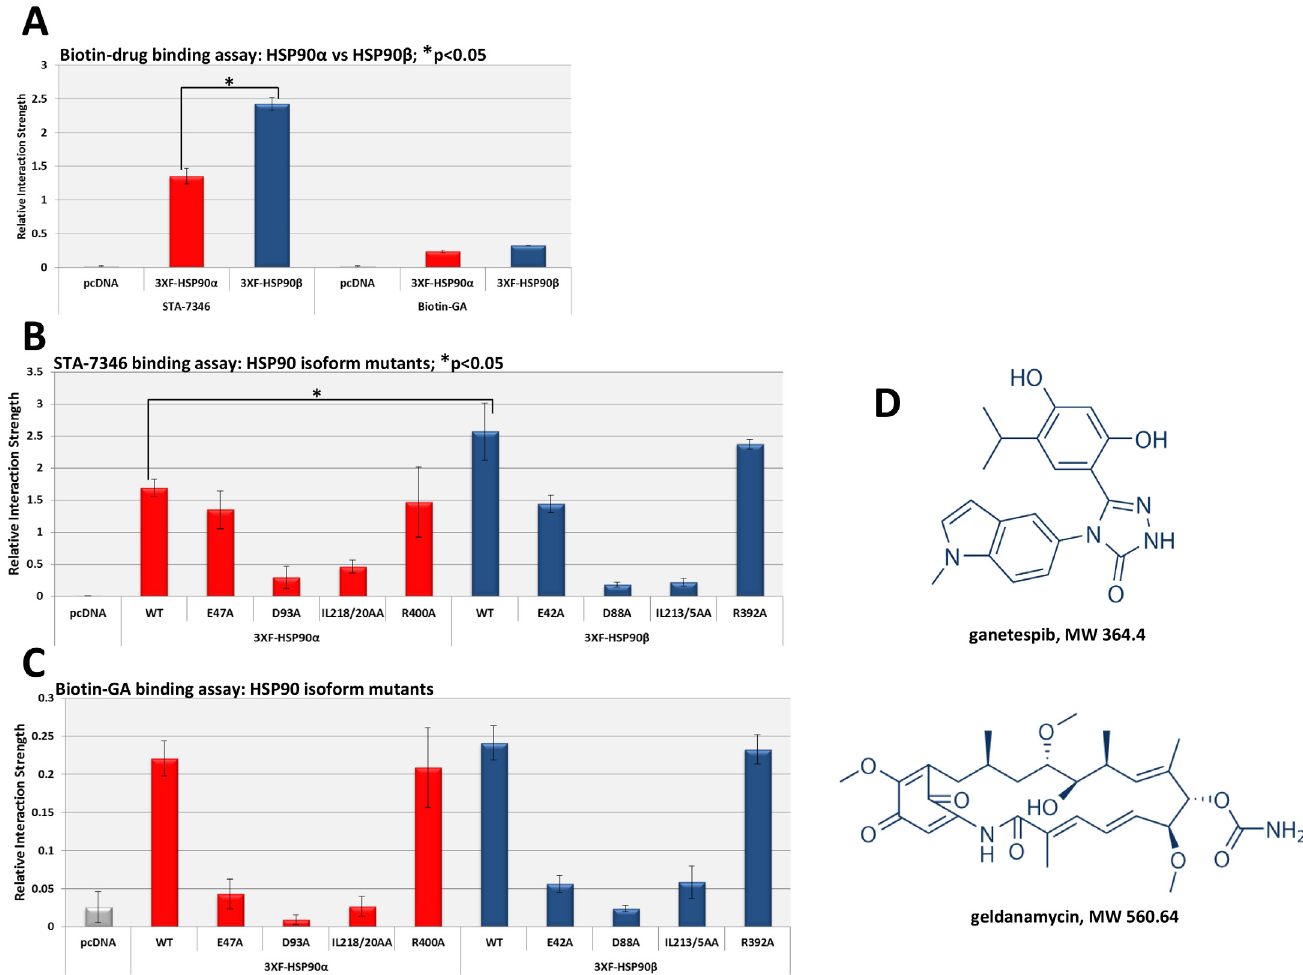
Fig 5. Interaction of HSP90 inhibitors with HSP90 isoforms. (A) Comparison of the relative interaction strength of STA-7346 and biotin-GA for each HSP90 isoform: HEK293 cells transfected with each HSP90 isoform were harvested, applied to an STA-7346 or biotin-GA coated streptavidin plate and assayed for interaction. The difference in relative interaction strength of HSP90 α and HSP90 β for STA7346 was statistically significant (p < 0.05) (see Methods). (B) Relative interaction strength of STA-7346 with each HSP90 WT and mutant isoform: HEK293 cells transfected with each HSP90 construct were harvested, applied to an STA-7346 pre-bound streptavidin plate, and assayed for interaction. The difference in relative interaction strength of WT HSP90 α and HSP90 β for STA7346 was statistically significant (p < 0.05), and comparable to the difference shown in panel A. (C) Relative interaction strength of biotin-GA with HSP90 WT and mutants: HEK293 cells transfected with each HSP90 construct were harvested, applied to a biotin-GA pre-bound streptavidin plate, and assayed for interaction (see Methods). (D) Chemical structures of ganetespib and geldanamycin: Images taken from selleckchem.com